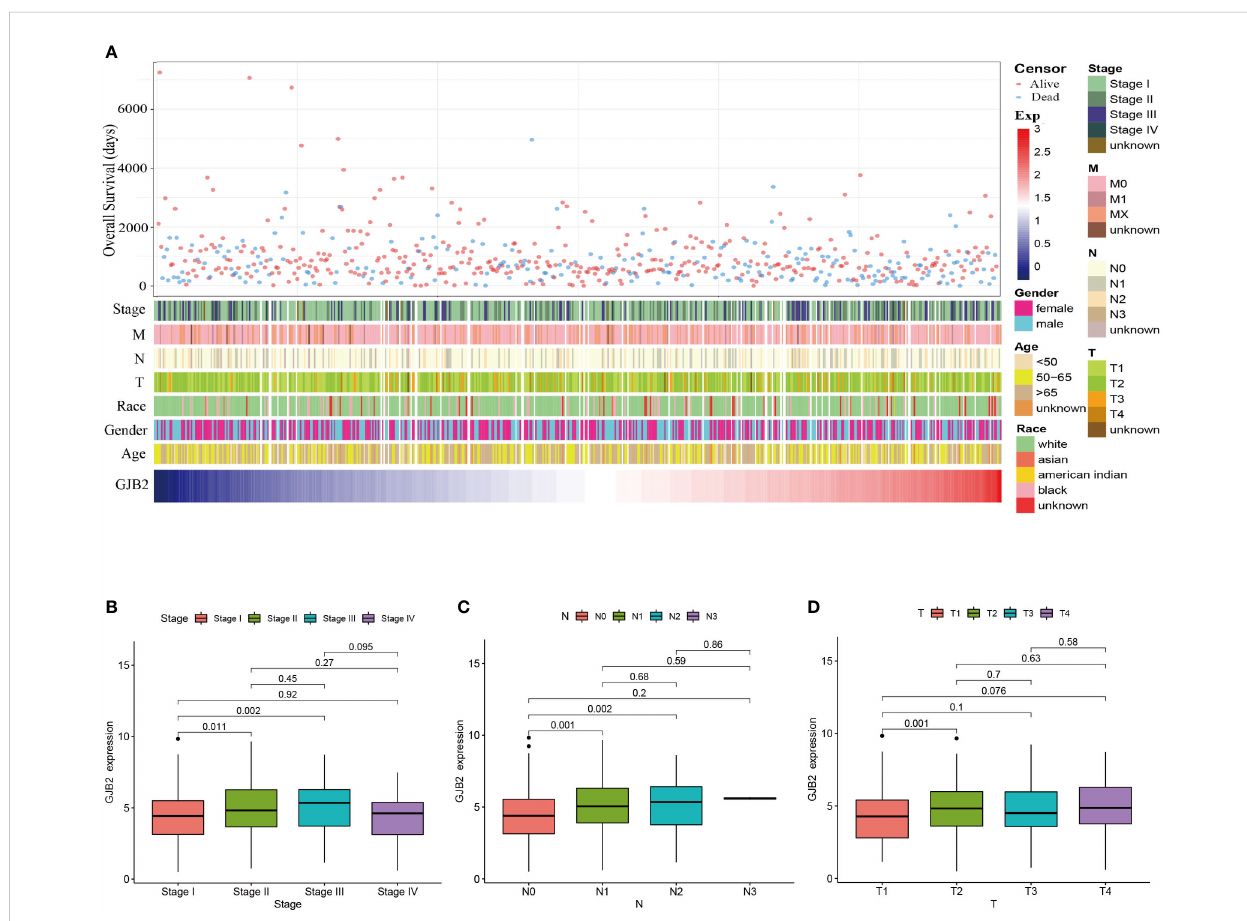
FIGURE 2 Association between GJB2 mRNA expression and clinical characteristics of LUAD. (A) The landscape of GJB2 -related clinical features of LUAD in the TCGA database. (B – D) Comparison of GJB2 mRNA expression based on patient ’ s individual cancer, nodal metastasis, and tumor